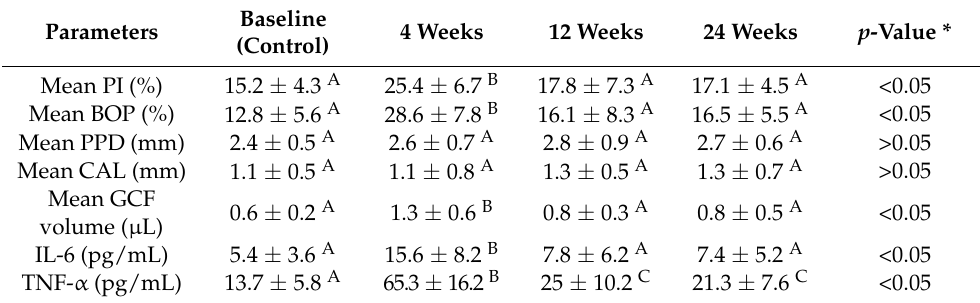
Table 2. Gingiva crevicular fluid (GCF) flow rate and periodontal parameters observed in the study.